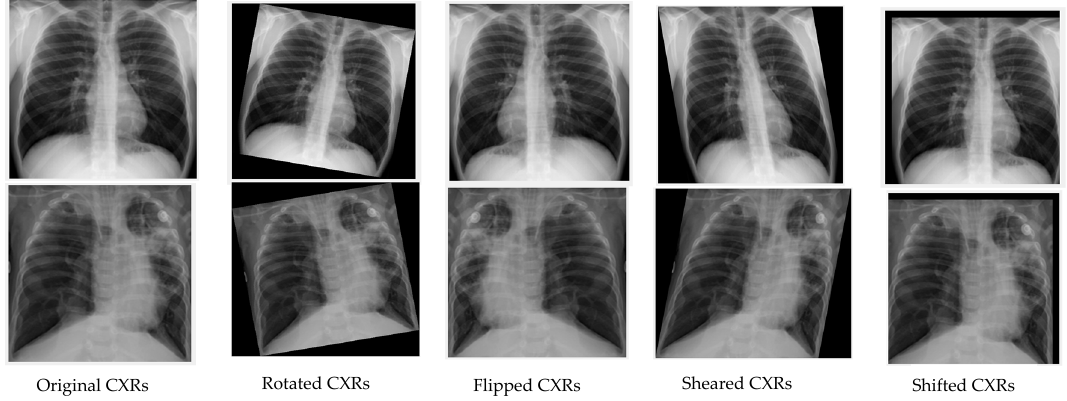
Figure 10. Augmented CXRs using rotation, flipping, shearing, and shifting.